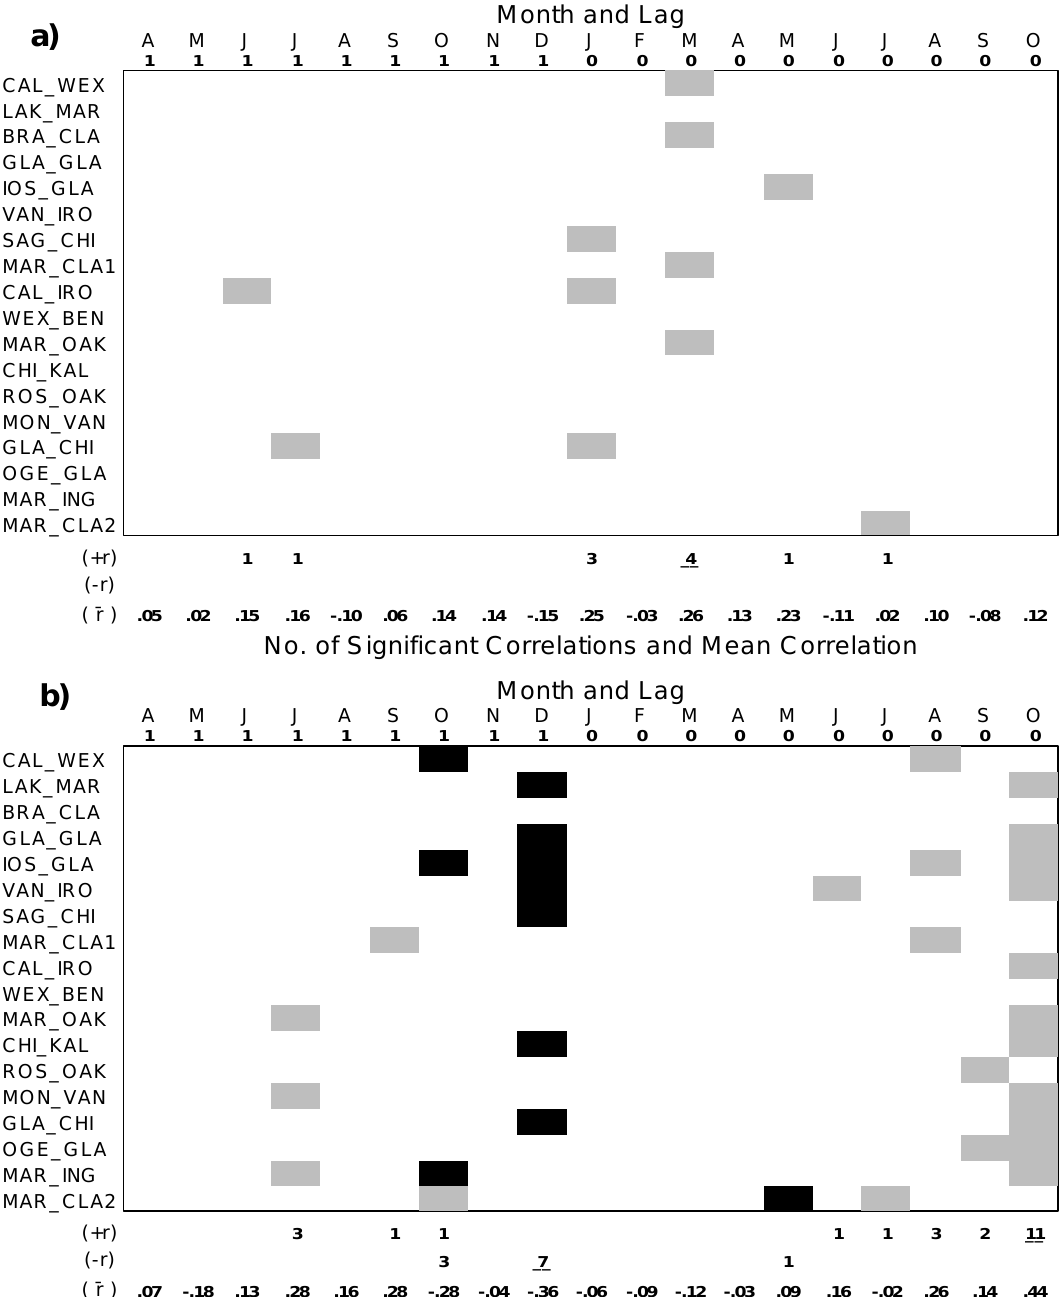
Figure 4. Pearson’s correlation coefficients between the standardized basal area index (BAI) growth chronologies of 18 full-sib families of hybrid poplar ( P. × smithii ) with monthly climate variables: (a) mean temperature; and (b) total precipitation. The analysis was conducted from 1987–2008 and spanning two growing seasons from April of the prior year (lag 1 = t − 1) to October of the current year (lag 0 = t). Significant (P < 0.05) positive relationships denoted by gray boxes, and significant (P < 0.05) negative relationships indicated by black boxes. The number of significant positive and negative correlation coefficients are shown below each figure with the highest number for each underlined. The mean correlation coefficient for each month is also